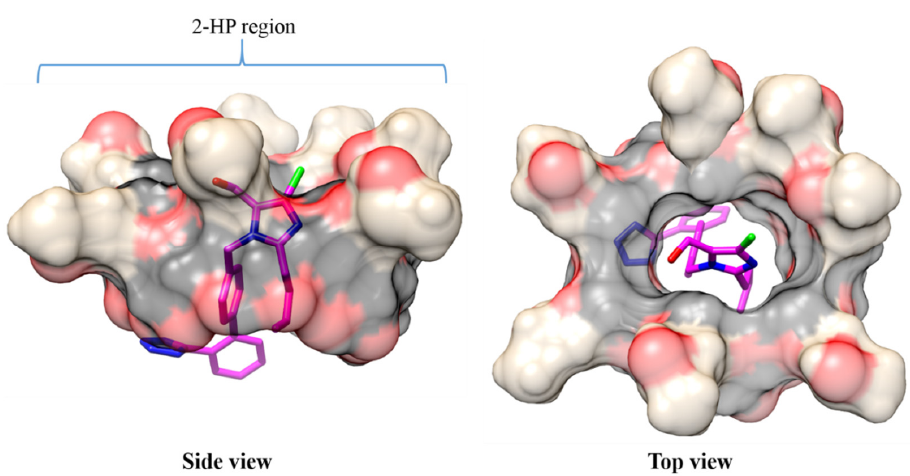
Figure 8. The optimal conformation of losartan into 2-HP- β -CD as obtained by molecular docking calculations. 2-HP- β -CD is depicted as transparent surface and the chlorine atom of losartan is in green. For simplicity, hydrogen atoms are not displayed.